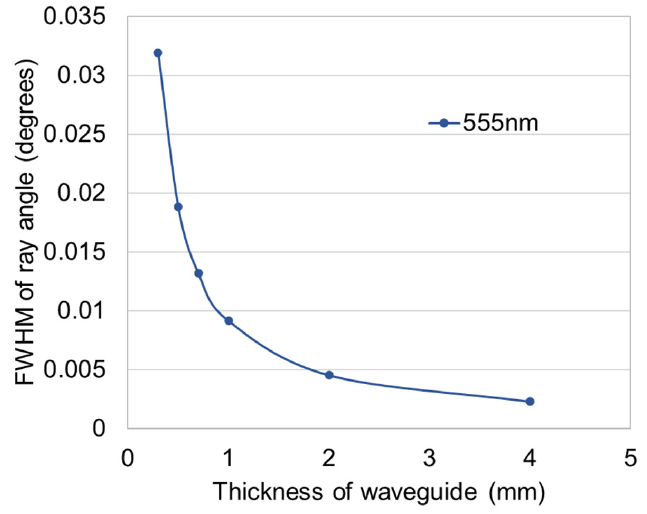
Figure 3. Calculation results of display resolution by conventional volume holographic waveguide with one-sided image input.